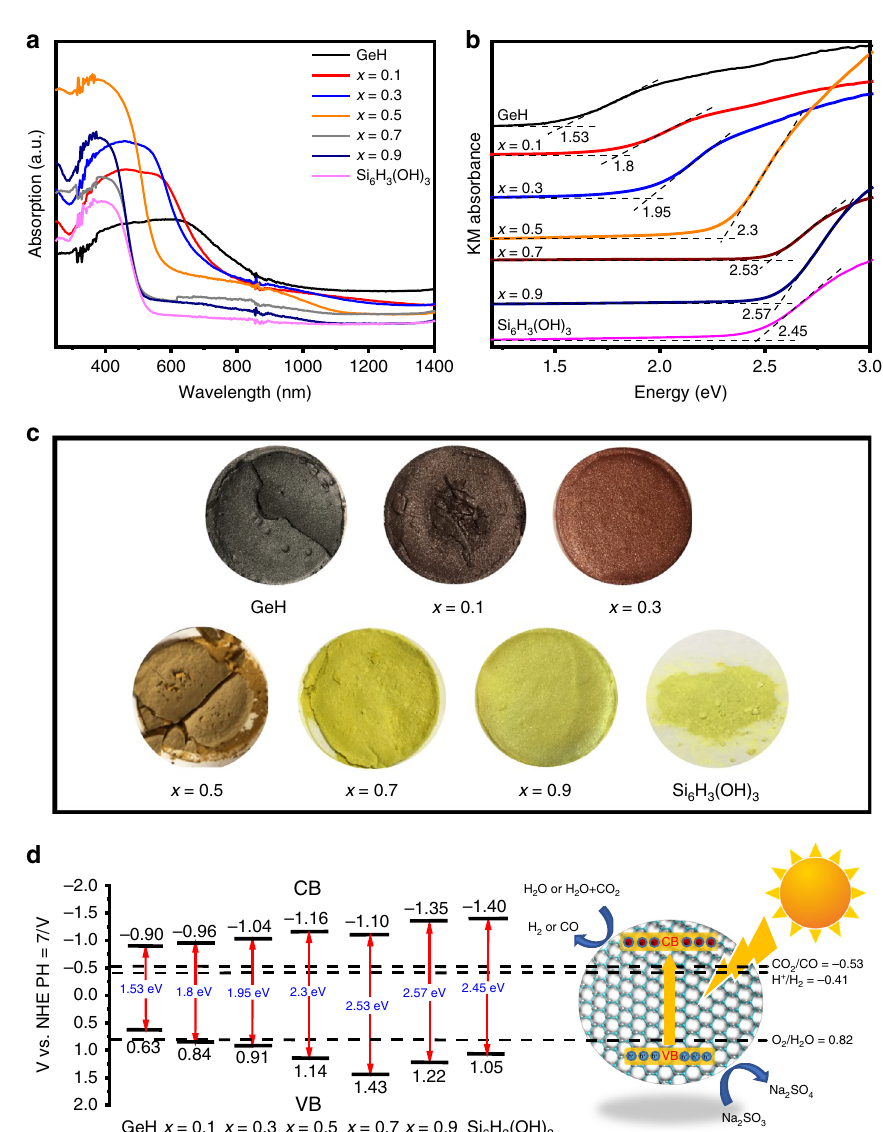
Fig. 5 Optical properties and energy band structure of gersiloxenes. a UV – vis diffuse re fl ectance spectra and b Tauc plots of gersiloxenes ( x = 0.1, 0.3, 0.5, 0.7, 0.9), GeH and Si 6 H 3 (OH) 3 . c The optical images of GeH, Si 6 H 3 (OH) 3 , and gersiloxenes with x = 0.1, 0.3, 0.5, 0.7, 0.9. d Energy band structure of gersiloxenes with different x values and GeH and Si 6 H 3 (OH) 3 for CO 2 reduction to CO and H 2 evolution. VB valence band, CB conduction band. Source data are provided as a Source Data fi le.